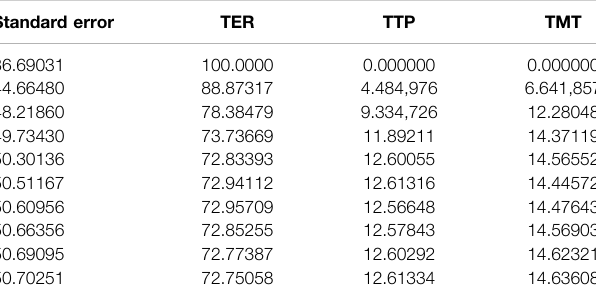
TABLE 4 | Variance Decomposition of TER (Ten-day erosion rate).